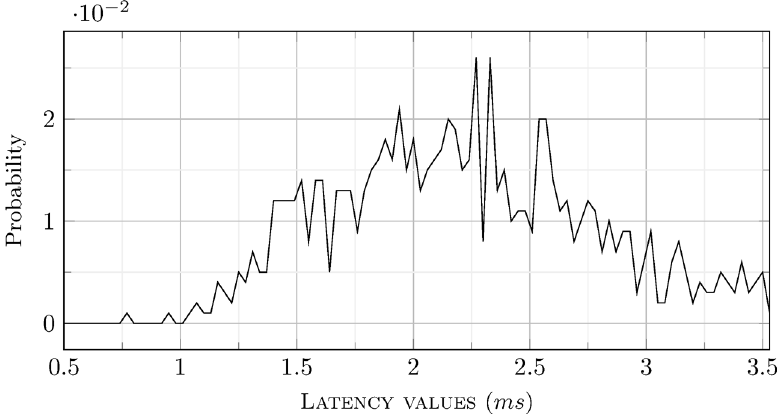
Figure 21. PDF for the seventeenth series of 1000 requests/responses.